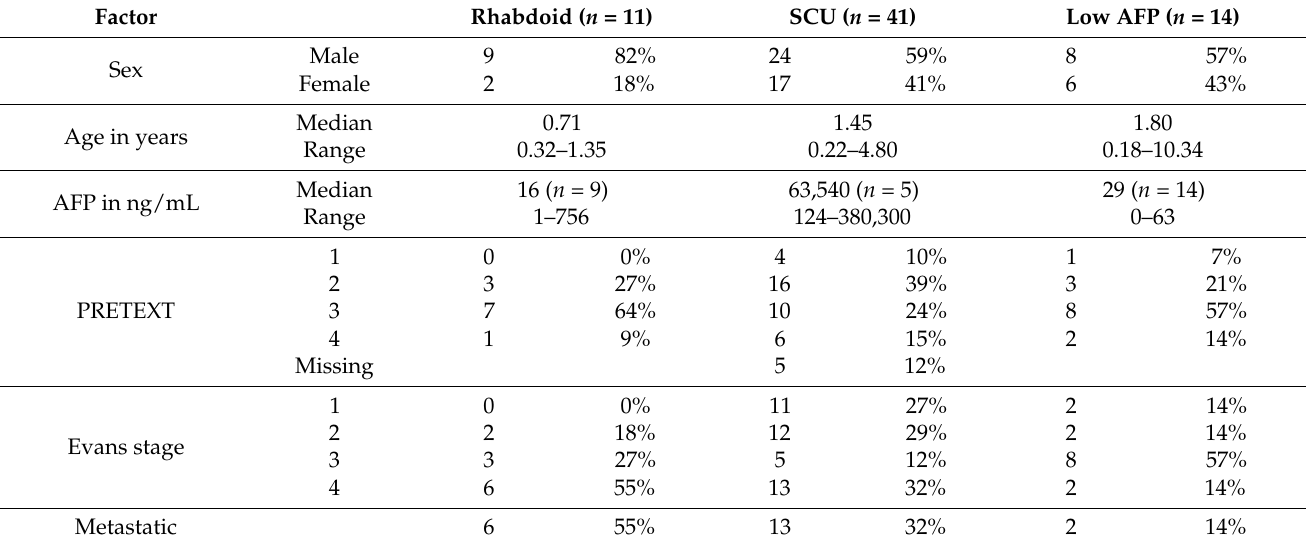
Table 1. Patient and tumor characteristics by group.